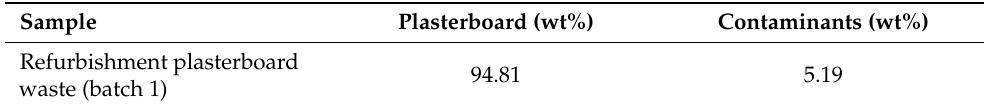
Table 2. Composition of the refurbishment plasterboard waste used for HSI system training.